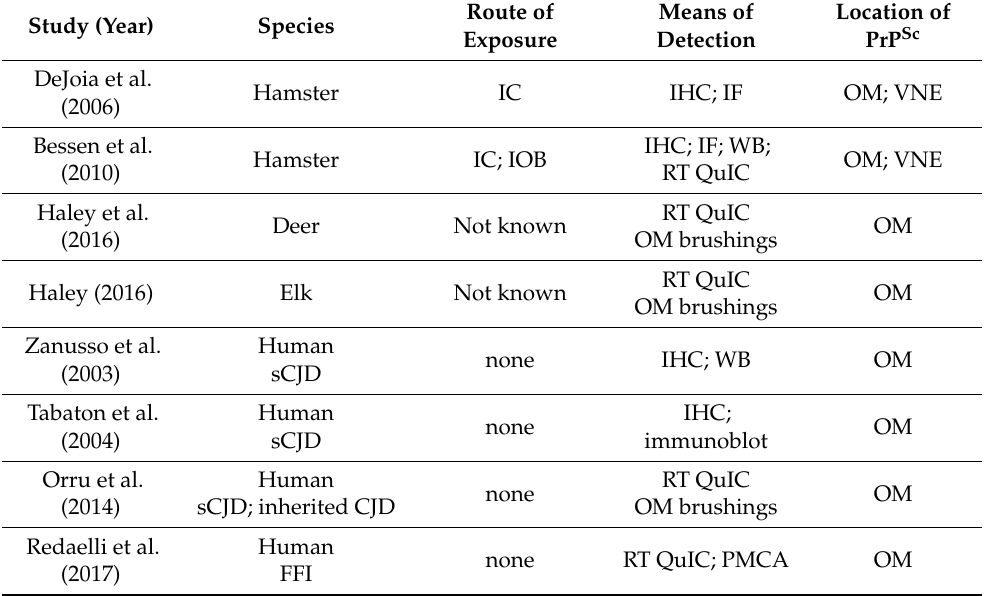
Table 2. Evidence for centrifugal spread of PrP Sc to nasal